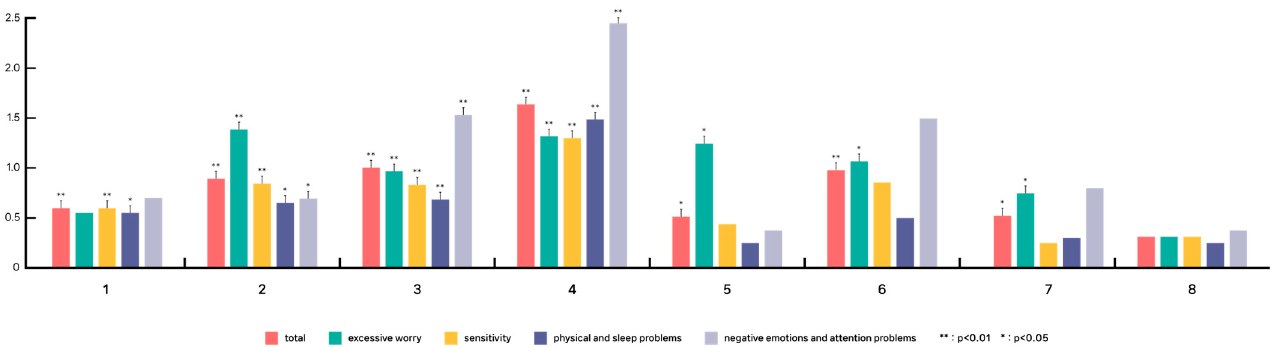
Figure 8. Effects of forest healing programs for children in each institution. Note: The x -axis represents the areas of soopchewon and forest healing centers located throughout the country. The y -axis is the value of the RCMA changed after the program progressed. (1: Chuncheon, 2: Hoengseong, 3: Forest Healing Center, 4: Chilgok, 5: Cheongdo, 6: Naju, 7: Jangseong, 8: Daejeon).